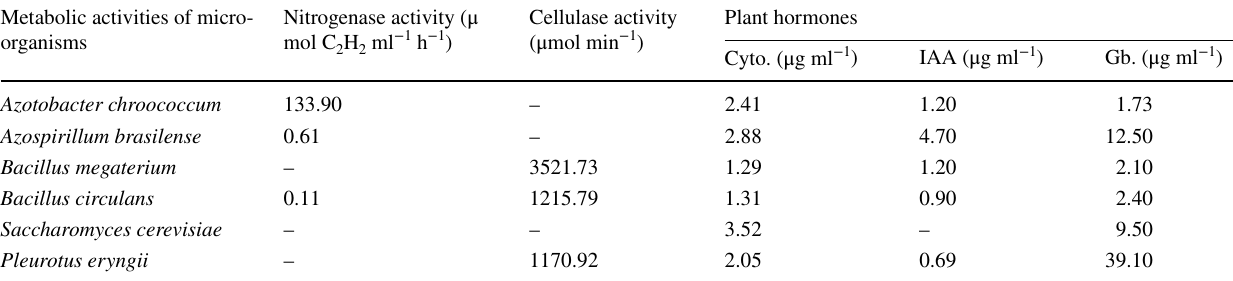
Table 1 Some metabolic activities of selected strains Metabolic activities of micro-